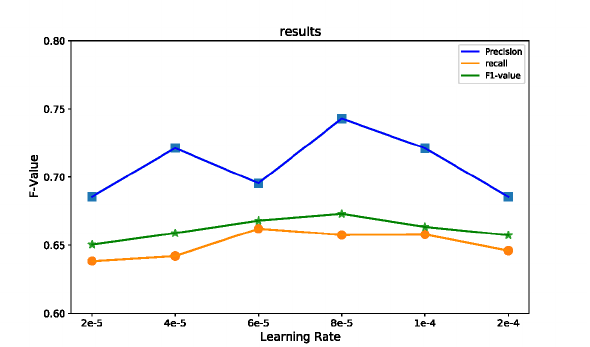
Figure 9. Comparison of experimental results of the model under different learning rates.